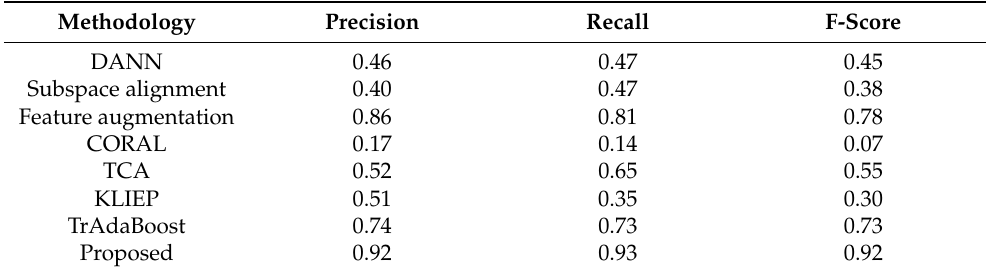
Table 4. Comparison of classification metrics for different transfer learning